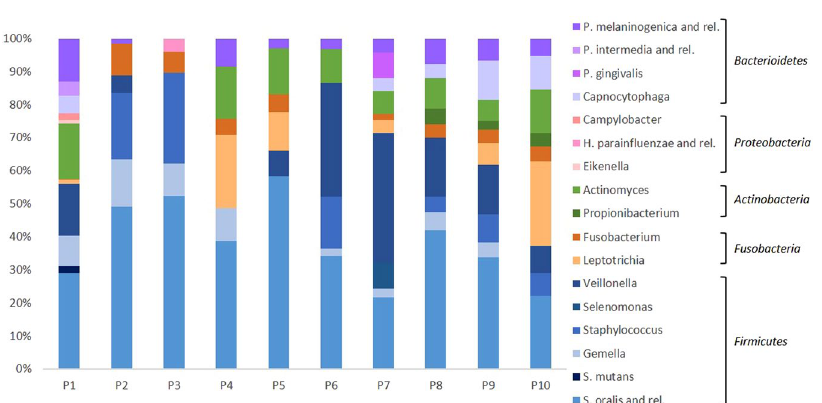
Figure 5. Relative abundance of bacterial targets detected by the OralArray, grouped for individual. For each individual (P1-P10), fluorescence intensities of saliva, lingual plaque, supragingival plaque, and healing cap were grouped and average relative contributions were calculated as percentage of the total fluorescence